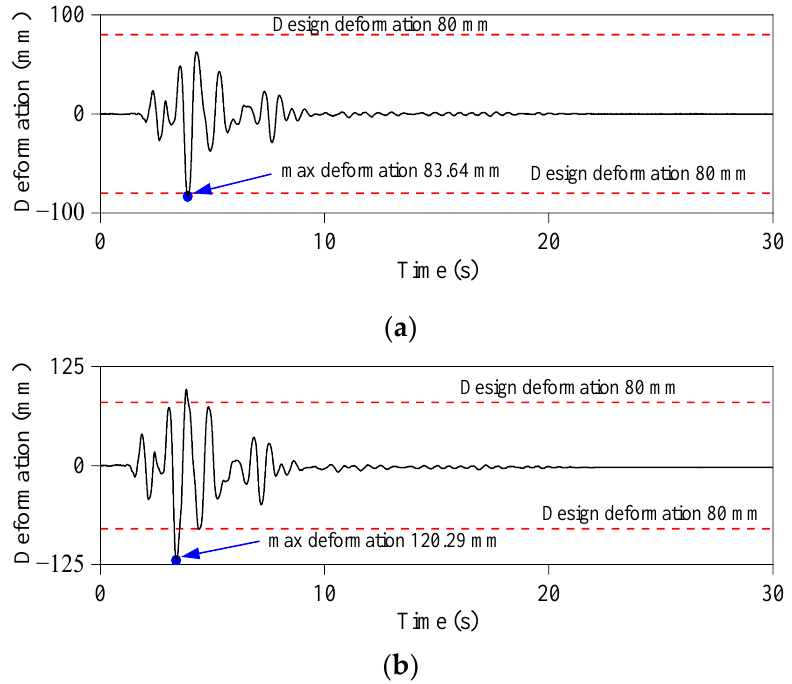
Figure 12. History of the displacement of the LNR subjected to: ( a ) Kobe_NP_0.60 g; ( b ) Kobe_NP_0.80 g.